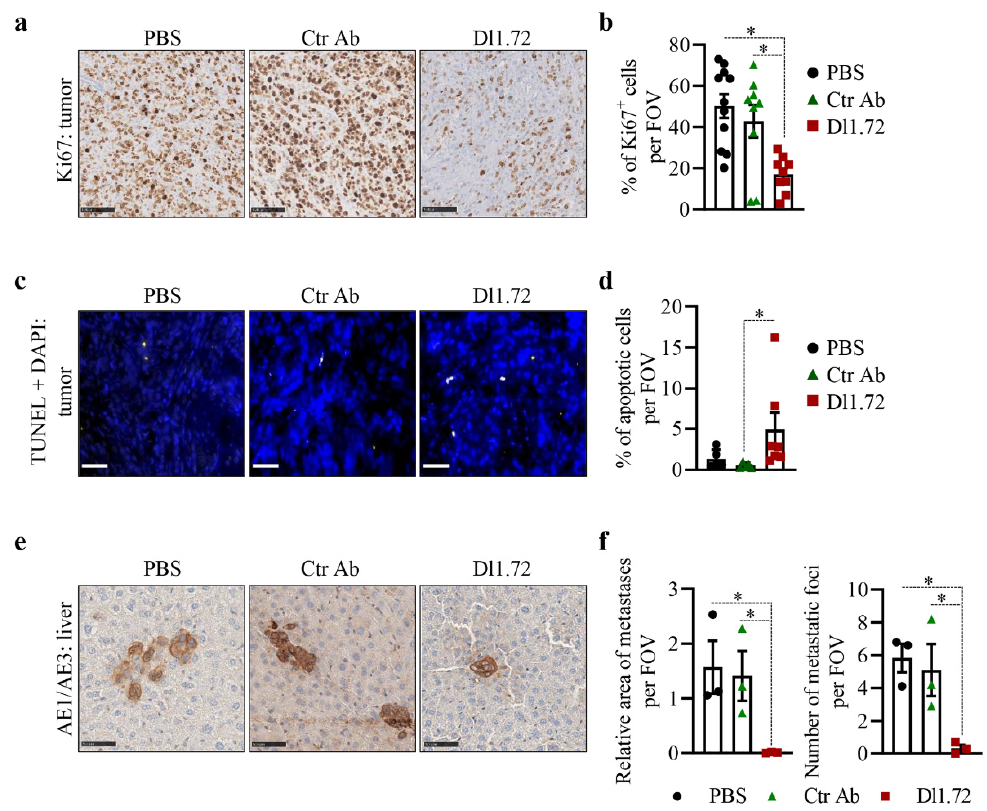
Figure 6. Treatment with anti-DLL1 Dl1.72 leads to reduced tumor cell proliferation, increased tumor cell apoptosis and impaired liver micrometastases in MCF-7 xenografts. ( a ) Representative IHC images of cross-sectioned tumors from mice treated with either PBS, Ctr Ab or Dl1.72 twice weekly for 12 weeks stained with Ki67 (proliferation marker). Scale bars, 100 µ m. ( b ) Quantification of Ki67 positive cells from the stained sections (PBS, n = 11 tumors; Ctr Ab and Dl1.72, n = 9 tumors/each group). ( c ) Representative IF images of cross-sectioned tumors from each group stained with TUNEL method (apoptotic cells, yellow) and DAPI (nuclei, blue). Scale bars, 50 µ m. ( d ) Quantification of apoptotic cells (PBS and Ctr Ab, n = 5 tumors/each group; Dl1.72, n = 7 tumors). ( e ) IHC representative images of cross-sectioned livers stained with pan-cytokeratin AE1/AE3 antibody. Scale bars, 100 µ m. ( f ) Quantification of liver relative areas (mm 2 ) occupied by AE1/AE3 + cells and number of liver micrometastatic foci (i.e., number of AE1/AE3 + areas) of indicated groups ( n = 3 tumors/group). All quantifications were performed in ten random fields of view (FOVs) at 10x magnified images from each tumor ( b , d ) and liver ( f ) cross-section. Data are expressed as mean values ± SEM. *, p < 0.05 (Mann–Whitney test).